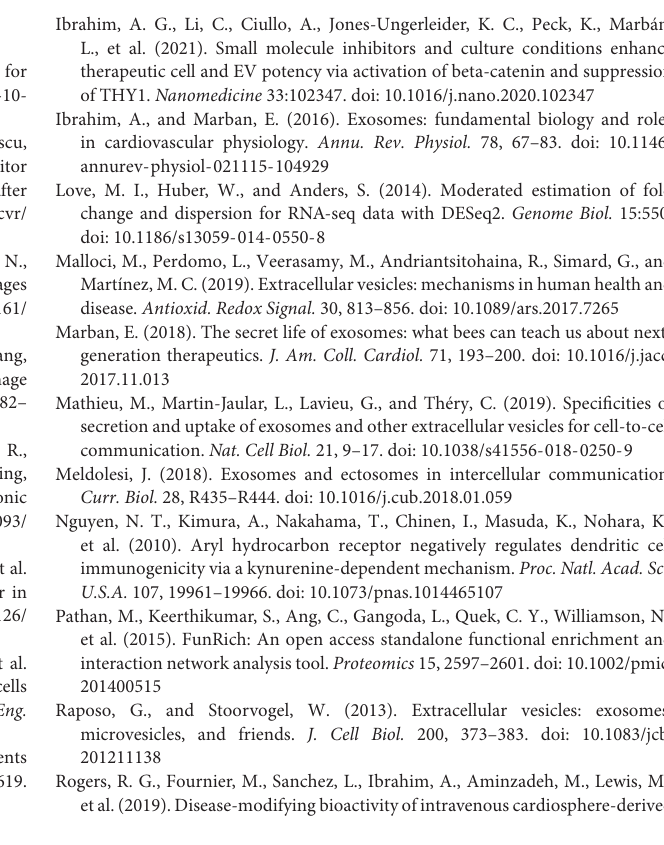
post-transduction. Unpaired, two-tailed t -test used for analysis. Error bars represent standard deviation. ∗ p < 0.05, ∗∗ p < 0.01, and ∗∗∗ p < 0.001. Supplementary Figure 2 | Removal of extra-vesicle protein does not change inhibit immunomodulatory function in BMDM. (A) Total protein concentration of ultrafiltration and SEC purified EV preparations. (B) EV concentrations normalized by volume. (C) EVs particle per µ g of protein. (D–F) Arg1, Nos2, and IL-6 expression in BMDMs treated with different preparations of TDO2 and HDF EVs. Two-group comparisons were analyzed using an unpaired, two-tailed t -test. Multiple comparisons were tested by one-way ANOVA with Sidek’s multiple comparison test. Error bars indicate standard deviation. ∗ p < 0.05, ∗∗ p < 0.01, and ∗∗∗ p < 0.001. Supplementary Figure 3 | Proteomic analysis of nHDF and nHDF TDO2 derived extracellular vesicles. (A) Visualization of the ratio of differentially expressed proteins (576) and the number of proteins mapped from each EV type, including unique sequences from nHDF (32) and nHDF TDO2 (13). (B) Comparison of the ratio of proteins based on their biological processes and molecular function. (C) Proteins significantly up- or downregulated in the TDO2-EV population delineated by their biological processes. Supplementary Figure 4 | Pre-treatment with nDHF TDO2 -EVs reduces the inflammatory reaction in BMDM. (A) Gene expression of ADAM17 in macrophages after treatment with EVs. (B) Expression of genes indicating M1 and M2 polarization. Fold change calculated versus untreated cells. (C–F) Gene expression of inflammatory markers after standard treatment with EVs or nHDF TDO2 -EV ( n = 3). (G) Heat map illustrating the gene expression of the NF κ B inflammatory complex and TLR adapter proteins MyD88 and TRIF after EV treatment versus controls ( n = 3 triplicates from two independent experiments). Two-group comparisons were analyzed using an unpaired, two-tailed t -test. Multiple comparisons were tested by one-way ANOVA with Sidek’s multiple comparison test. Error bars indicate standard deviation. ∗ p < 0.05, ∗∗ p < 0.01, and ∗∗∗ p <